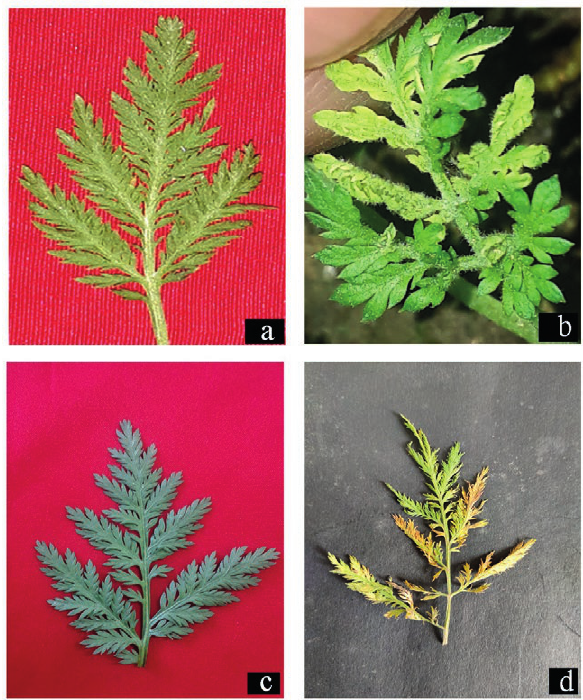
Figure 3. Chlorophyll mutants in Artemisia annua L.: a- Control, b-Semi-xantha mutant at seedling stage, c- Viridis mutant, d- aurea